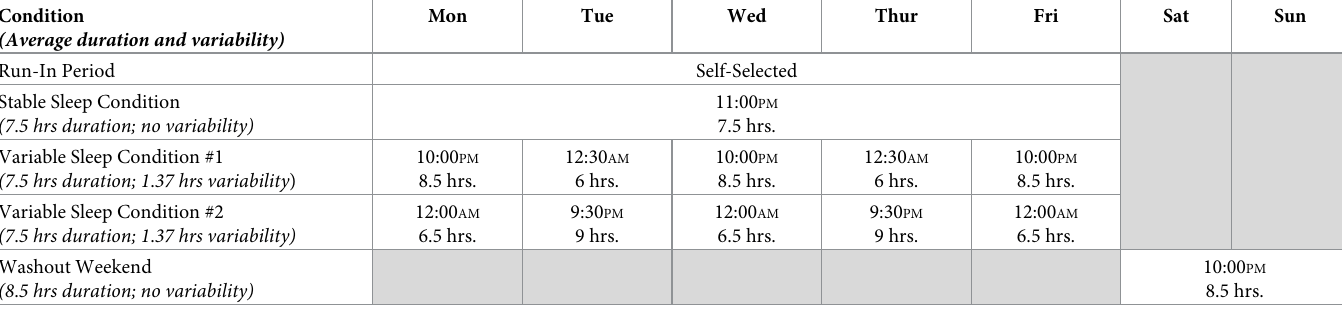
Table 1. Assigned bedtimes and sleep period lengths for each night within each sleep manipulation